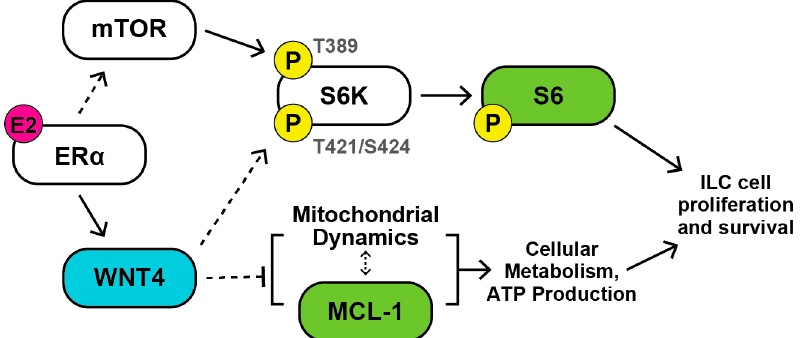
Figure 7. mTOR signaling and MCL-1 are key downstream targets of WNT4 in ILC cells. Our data identified mTOR signaling and mitochondrial function/dynamics as key processes downstream of WNT4. In mTOR signaling, WNT4 regulated S6K-mediated S6 phosphorylation via regulation of S6K phosphorylation at the psuedo-substrate inhibition site (T421/S424). Upstream mTOR-driven phosphorylation of S6K (e.g., at T389) was still necessary for S6K activity. WNT4 also